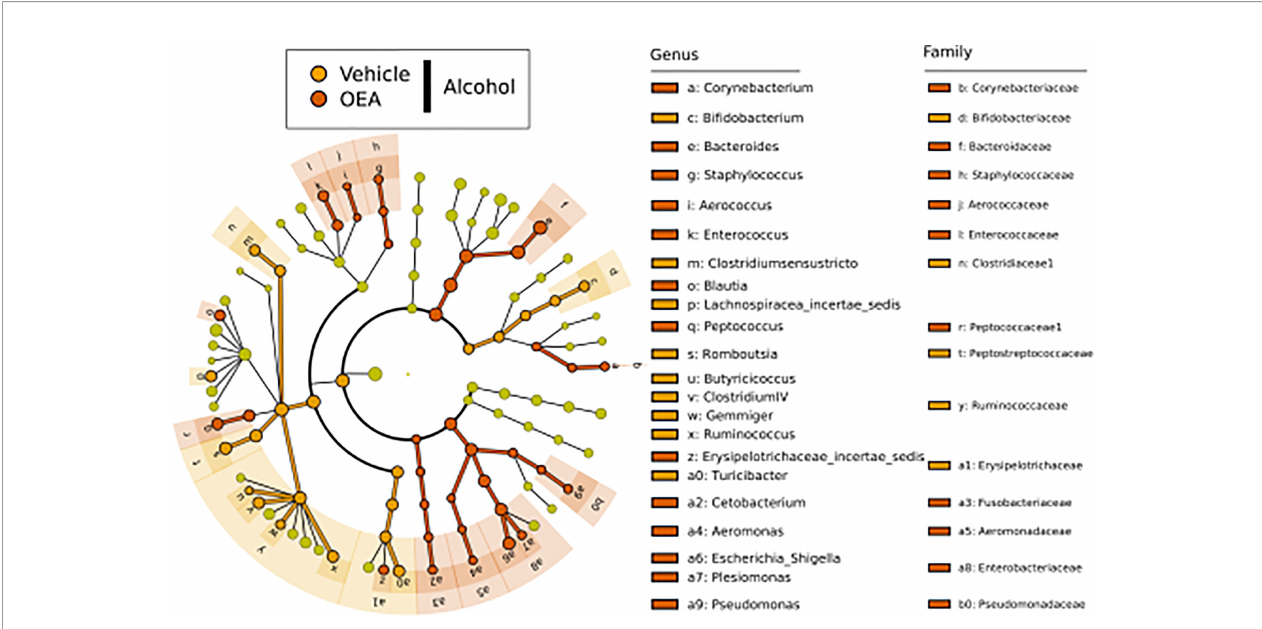
FIGURE 5 | LEfSe biomarker identi fi cation for the comparison of genera relative abundance between the OEA-supplemented vs . the non-OEA-supplemented group of alcohol-intoxicated rats. Signi fi cant biomarker taxon for each group was obtained with a Kruskal – Wallis test among classes ( a = 0.05), and only biomarkers with a logarithmic linear discriminant analysis score higher than 2.0 were retained. Alcohol + vehicle group, n = 8; alcohol + OEA group, n = 14.